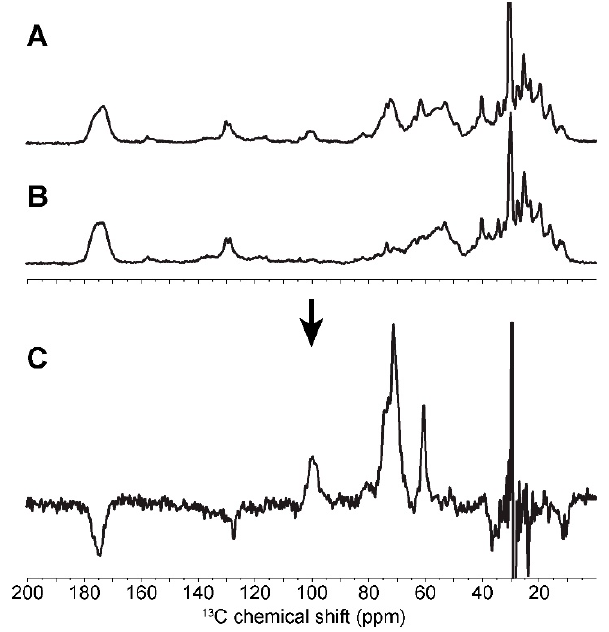
Figure 7. 1D cross ‐ polarisation 13 C solid ‐ state NMR spectra of whole C. reinhardtii wt cells ( A ) and sta 6 ‐ 1 starchless strain cells ( B ). Subtraction of these spectra results in the 1D spectrum of in situ native starch ( C ).